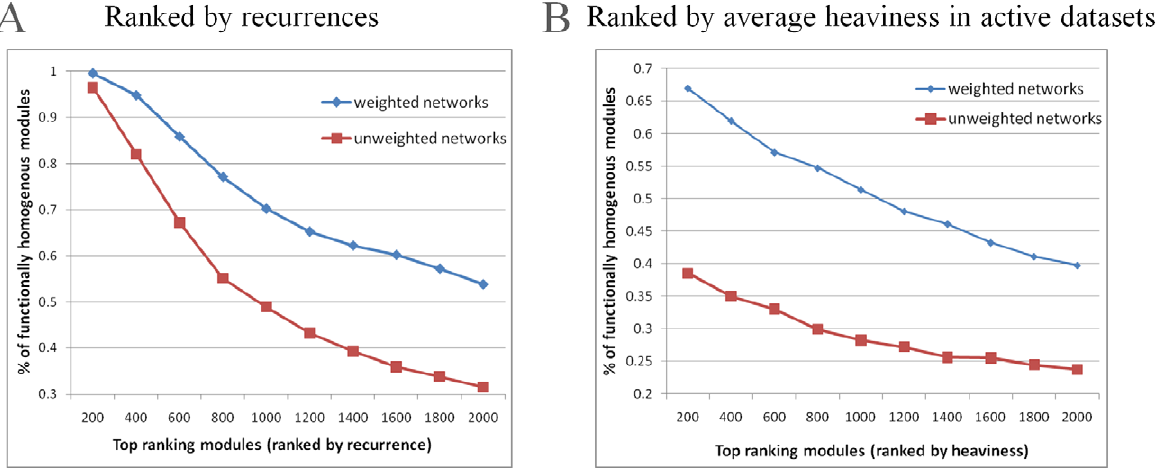
Figure 4. Comparison between weighted and unweighted network analysis. The weighted networks were transformed to unweighted networks by dichotomizing edges with an expression correlation cutoff of 0.6. The proposed tensor method was then applied to both weighted and unweighted networks. We compared rates of functional homogeneity detected in the top K ~ 200,400, (cid:4)(cid:4)(cid:4) ,2000 modules, ranked by ( A ) recurrences or ( B ) average heaviness in their datasets of occurrence. Weighted graph analysis consistently outperforms unweighted graph analysis.